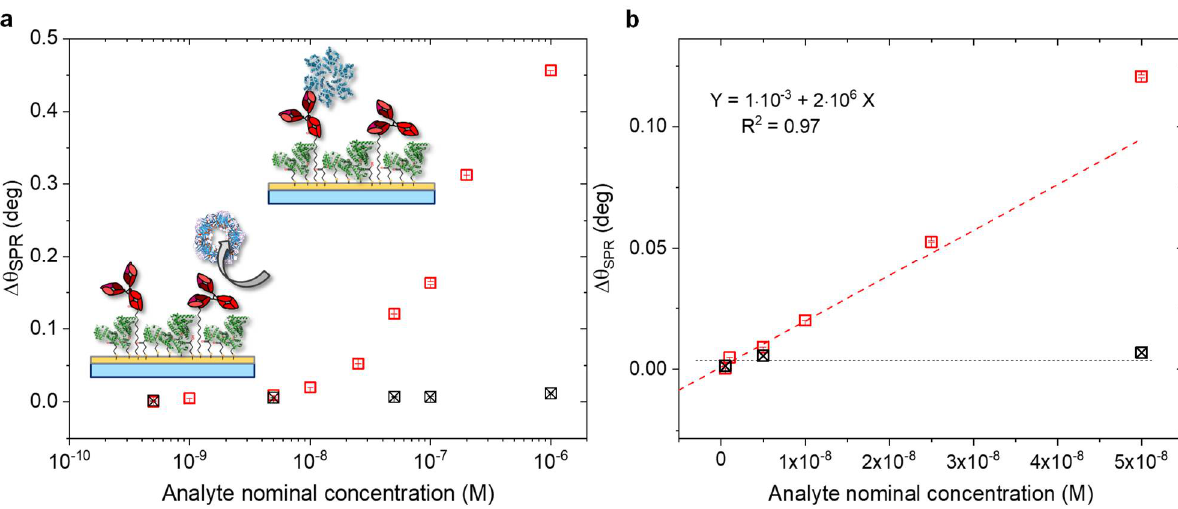
Figure 6. ( a ) SPR angular shift vs nominal concentration of HIV-1 p24 (red squares) and CRP (black squares) in the cross-reactivity test, performed on the SAM modified surface (semi-log scale). ( b ) Linear plot of SPR response performed on modified anti-p24 SAM, upon the p24 (red squares) and CRP (black squares) binding vs. analyte nominal concentration. The regression of the linear portion of p24 response is shown as the red dotted line; the average signal of the negative control is depicted as the black dotted line. The average value of three replicate analysis and their standard deviation are reported.